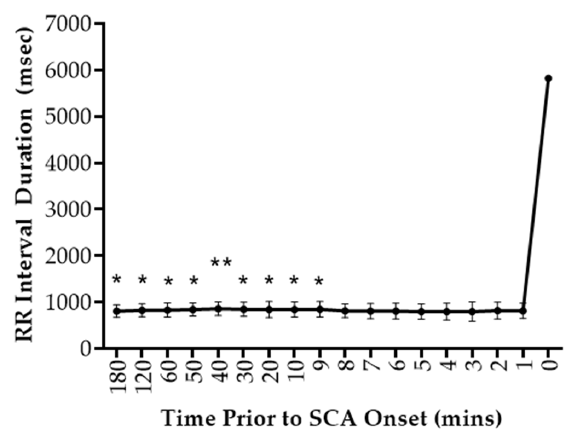
Figure 5. Time series plot of the change in R-R Interval duration prior to the onset of sudden cardiac arrest (n = 10). ECG recordings were taken from patients in the SCA cohort and subjected to processing via MATLAB. The results were recorded as mean R-R interval duration ( ± standard deviation) denoted by the error bars. Asterisks denote statistical significance by repeated measures ANOVA where * p < 0.05 and ** p < 0.01.